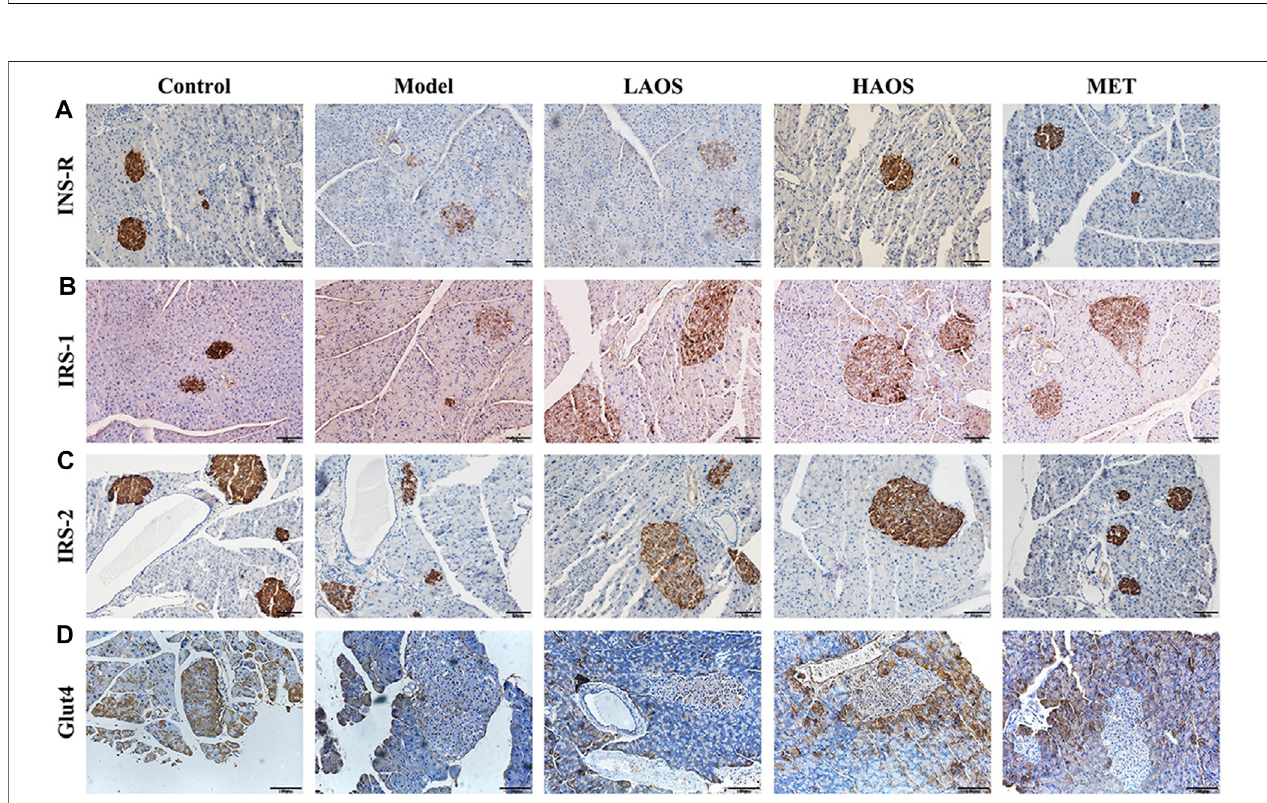
FIGURE 4 | Effect of AOS on INS-R, IRS-1, IRS-2, and Glut4 expression. Wax-embedded sections of db/m and db/db mice pancreas showing the expression of INS-R (A) , IRS-1 (B) , IRS-2 (C) , and Glut4 (D) as revealed by immunohistochemistry.